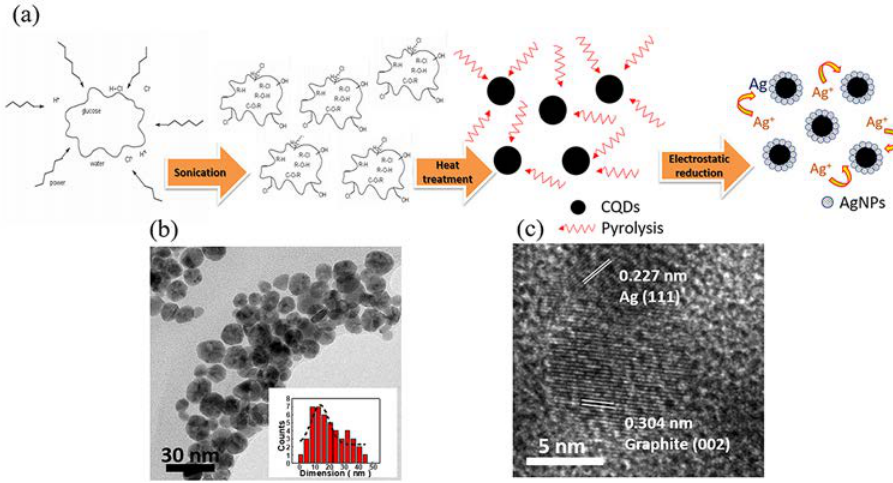
Figure 1. ( a ) Schematic illustrations for the formantion of CQD/AgNP nanoparticles. ( b ) Correlated TEM image and ( c ) HRTEM image of CQD/AgNP nanoparticles. The inset of Figure 1b presents the particle distribution with Gaussian fitting. For synthesizing AgNP-decorated CQDs functioning as broadband absorption probes, the cationic Ag(NH 3 ) 2+ ion was introduced in the CQD-contained solutions, which are preferentially reacted with O-H groups on CQD surfaces due to strong electrostatic attrac- tion, and in turn initiate the reduction of Ag clusters following the reaction presented as below [23], where R represents the CQDs. Specifically, the adhered Ag(NH 3 ) 2+ molecules on CQD surfaces are rapidly reduced to Ag as long as the -OH groups of CQDs are exposed to the Ag+ containing solutions. Thus, the oxidation and reduction reactions are ceased while the AgNPs are fully surrounded CQDs rather than directly formed in the solutions, which guarantees the well incorporation of AgNP shells with CQD cores. In